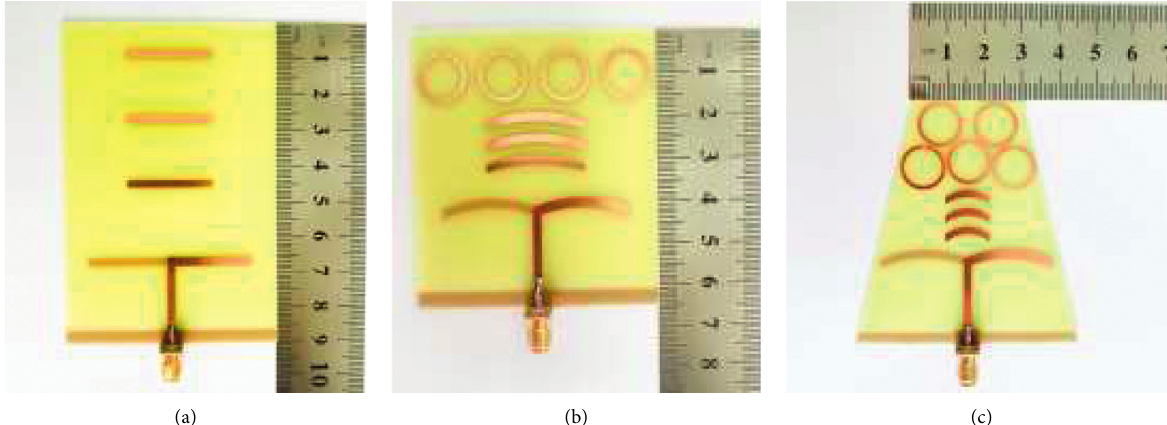
Figure 10: Fabricated quasi-Yagi antennas. (a) Reference quasi-Yagi antenna with straight arms (90mm). (b) Compact rectangle quasi-Yagi antenna with bent arms (65 mm). (c) Compact trapezoid quasi-Yagi antenna with bent arms (30mm).